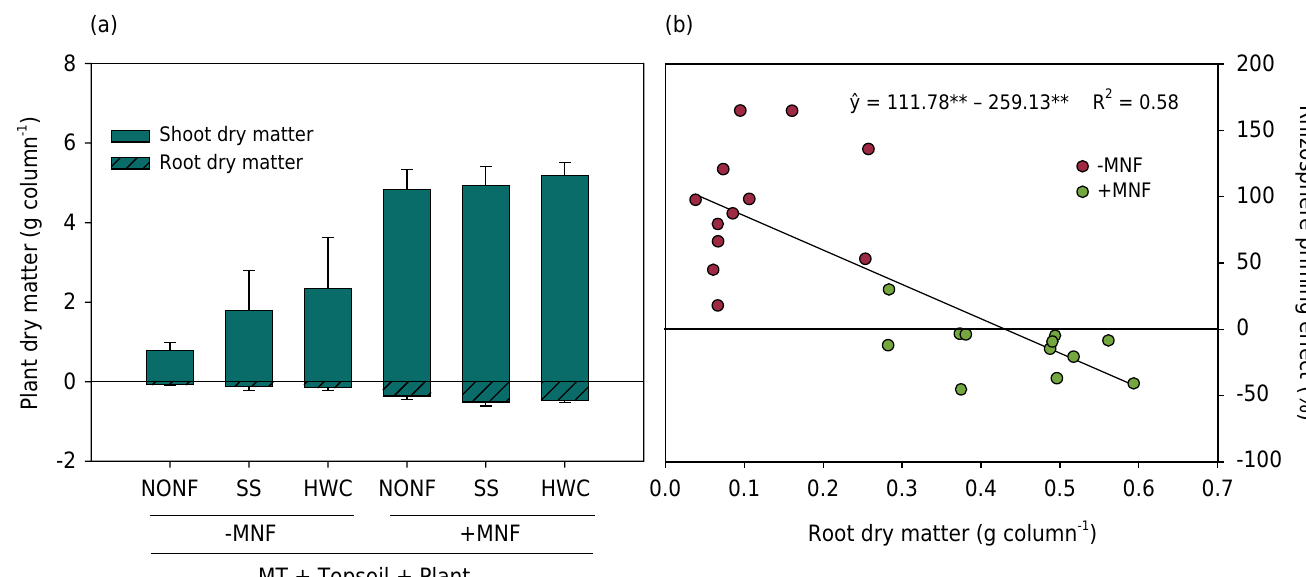
Figure 6. Shoot and root dry matter (g) of Crotalaria juncea after 78 days after the sowing in iron mining tailing + Topsoil (MT + Topsoil), without (-MNF) and with mineral-N fertilization (+MNF) and different organic-N fertilization (non-organic-N fertilization, sewage sludge - SS and household waste composting - HWC). Linear regression model adjustment to root dry matter of Crotalaria juncea and Rhizosphere priming effect (b). Vertical bars denote means ± 90 % confidence interval